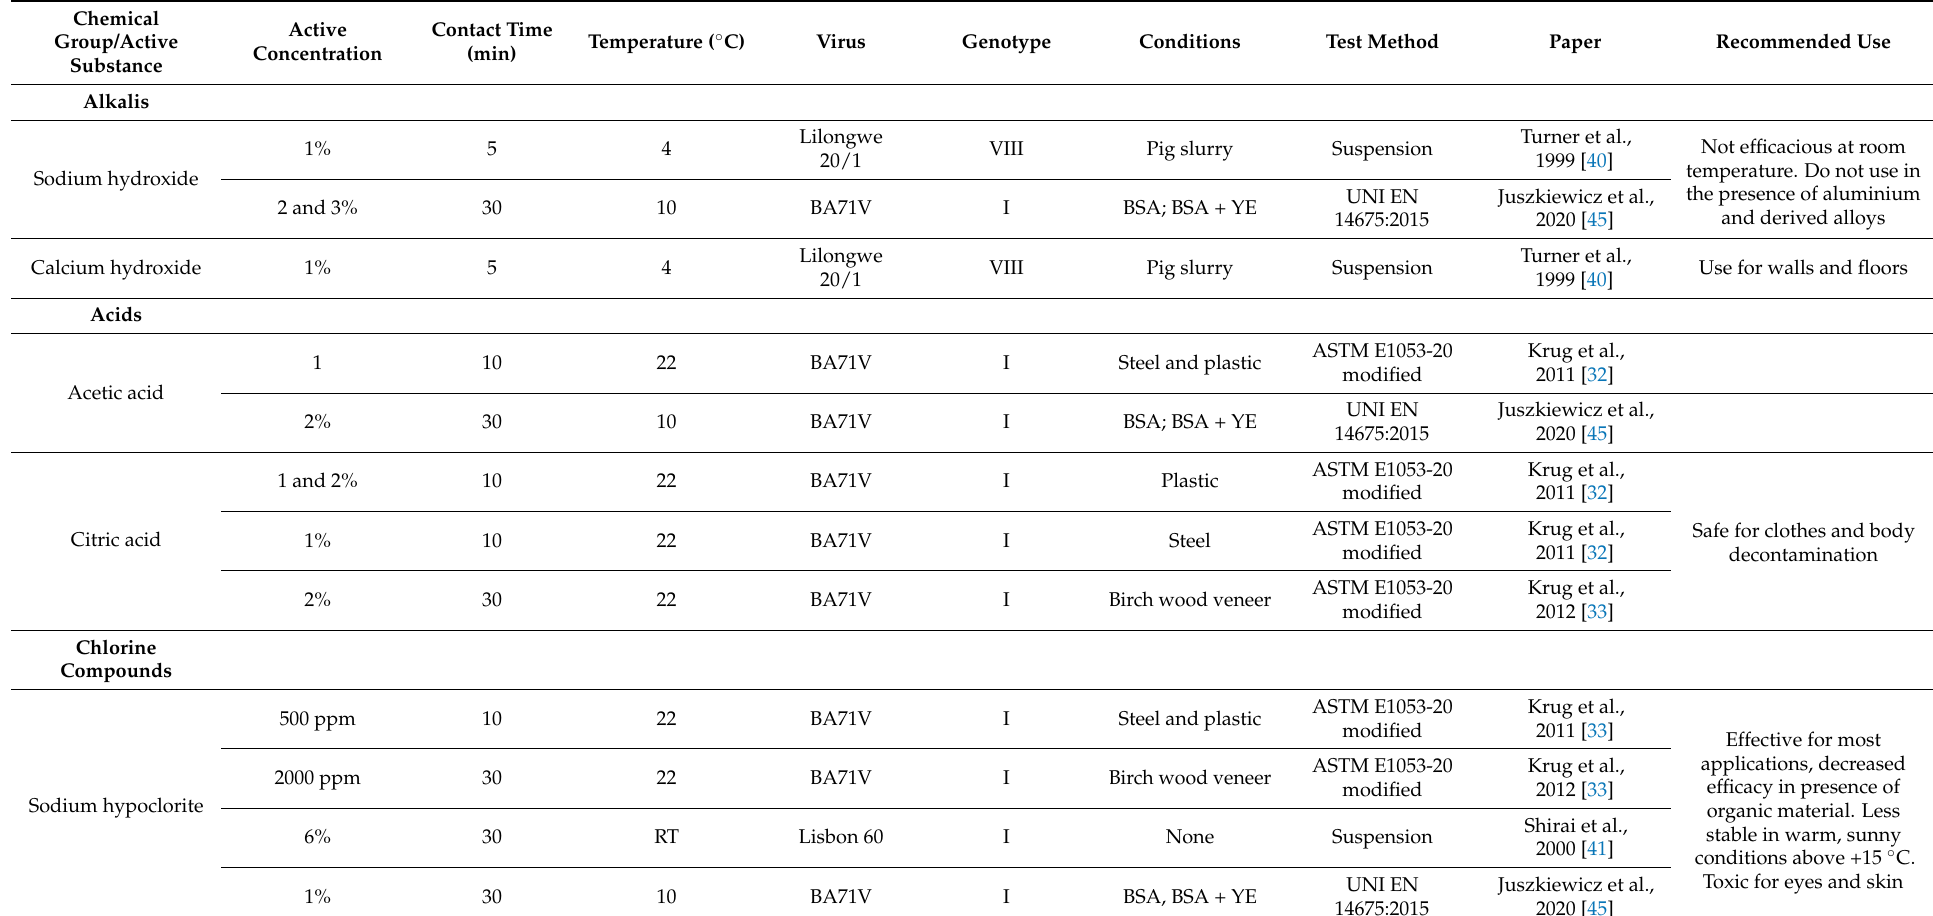
Table 2. List of tested and efficacious disinfectants against